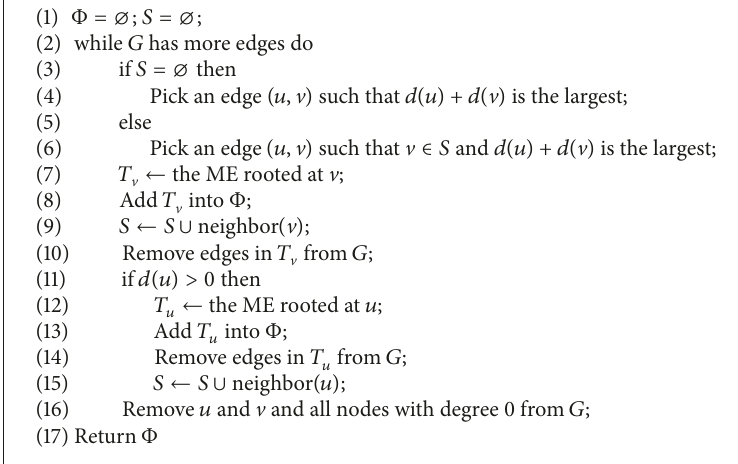
Algorithm 1: Monitoring minimization.